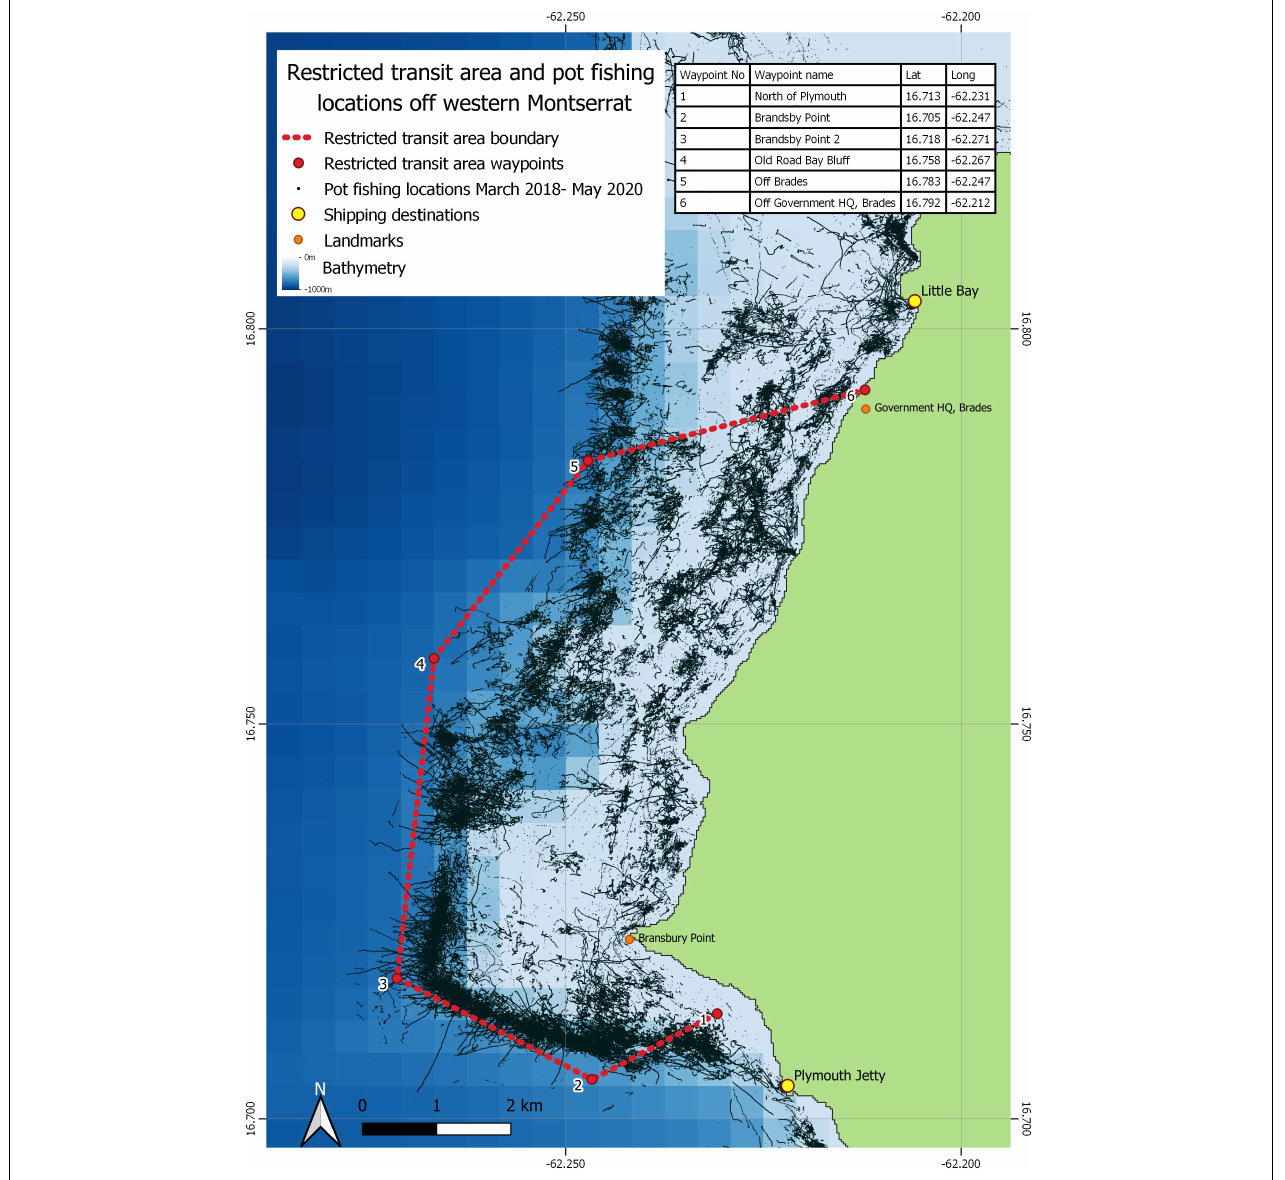
FIGURE 5 | Restricted transit area and locations of pot fishing in south west